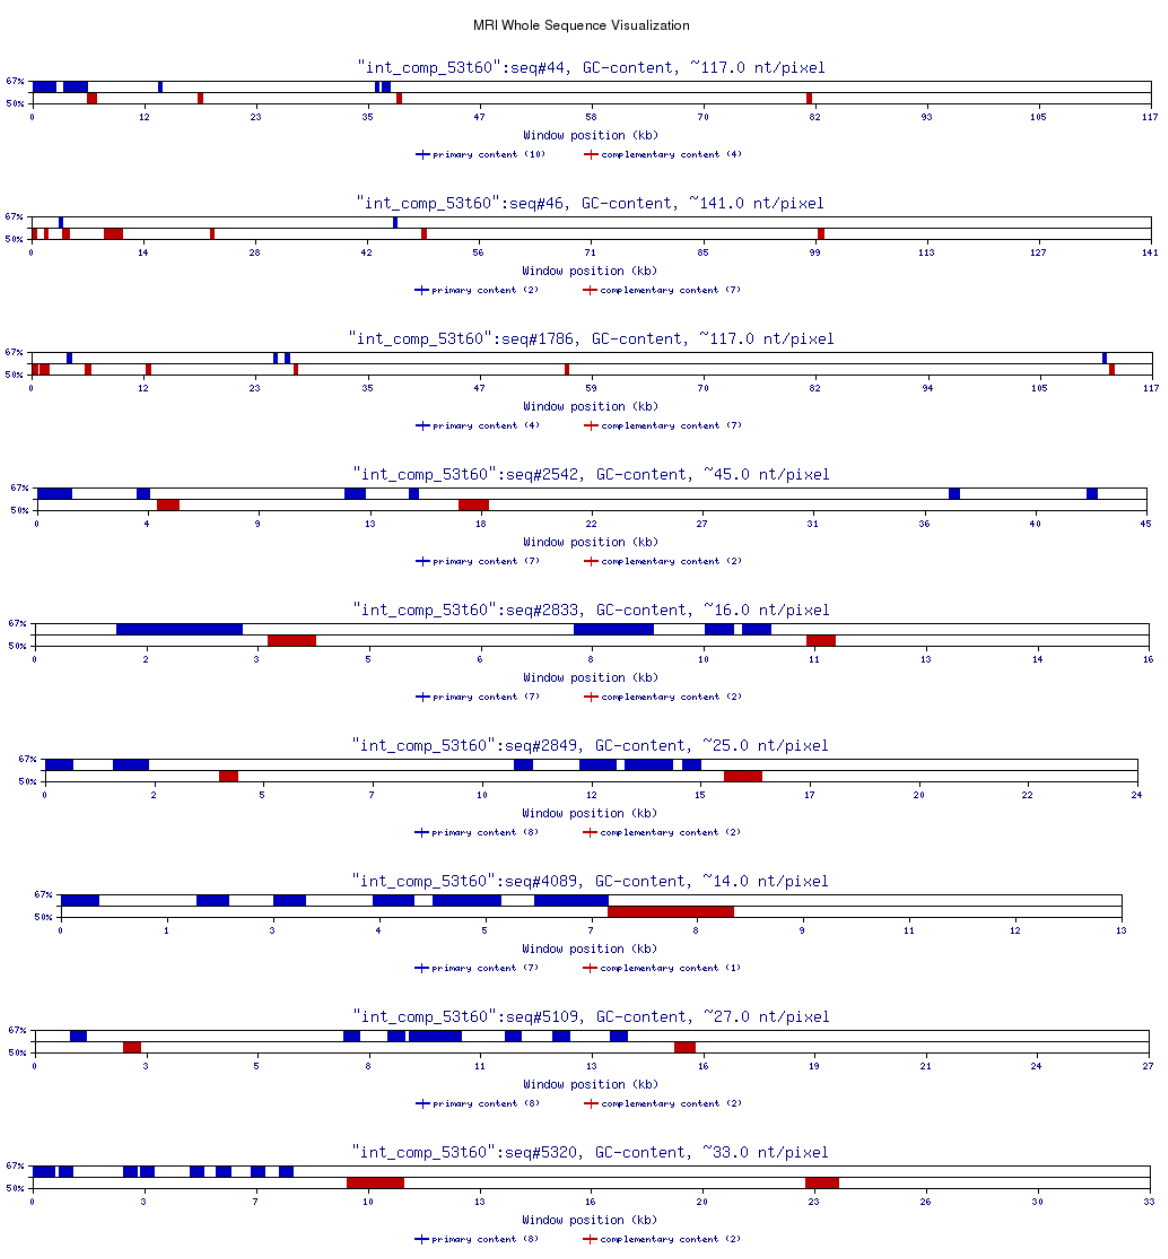
FIGURE 3. Visualization of G+C-rich (blue) and A+T-rich (red) MRI features in human introns using a 400-nt base window size. The scale for each sequence is independent and is given in its subheading in nucleotides per pixel. The figure represents a fragment of Fig. 17 in